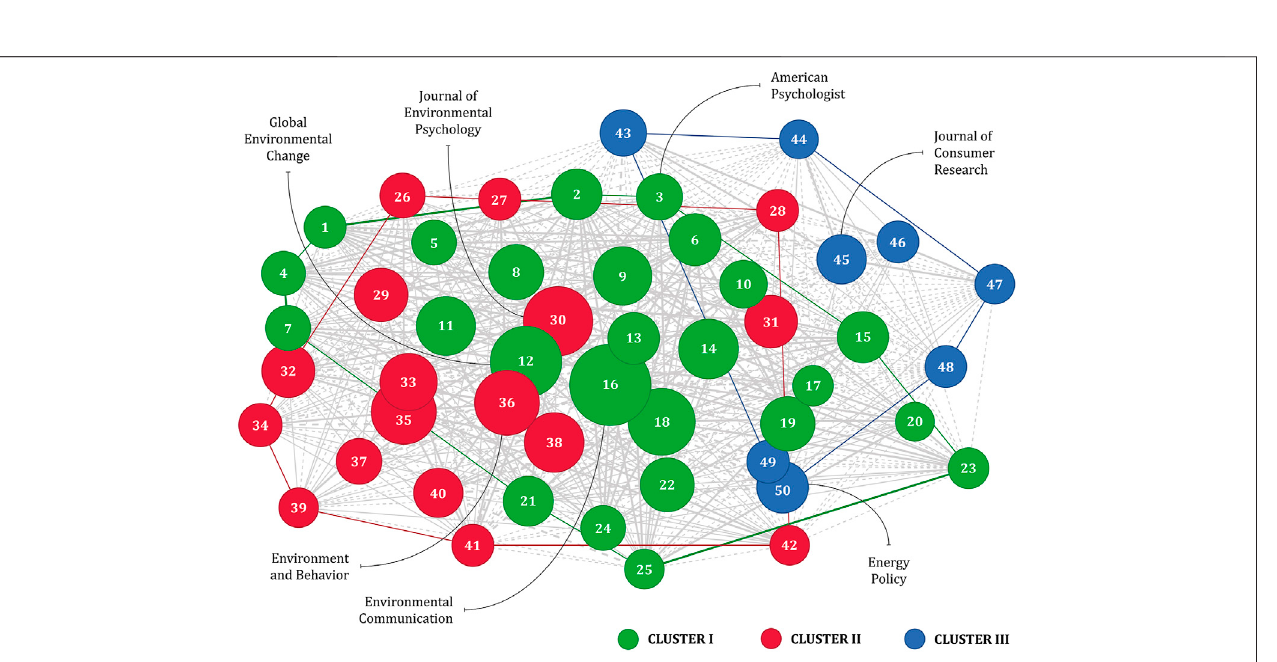
FIGURE 6 | 2010 – 2019 co-citation network; SWI (cid:1) 1.45; density (cid:1) 0.576; transitivity (cid:1) 0.815; diameter (cid:1) 3; degree centralization (cid:1) 0.360; average path length (cid:1) 1.426. Node numbers corresponding to the journals and their clusters are available in the Supplementary Table S5